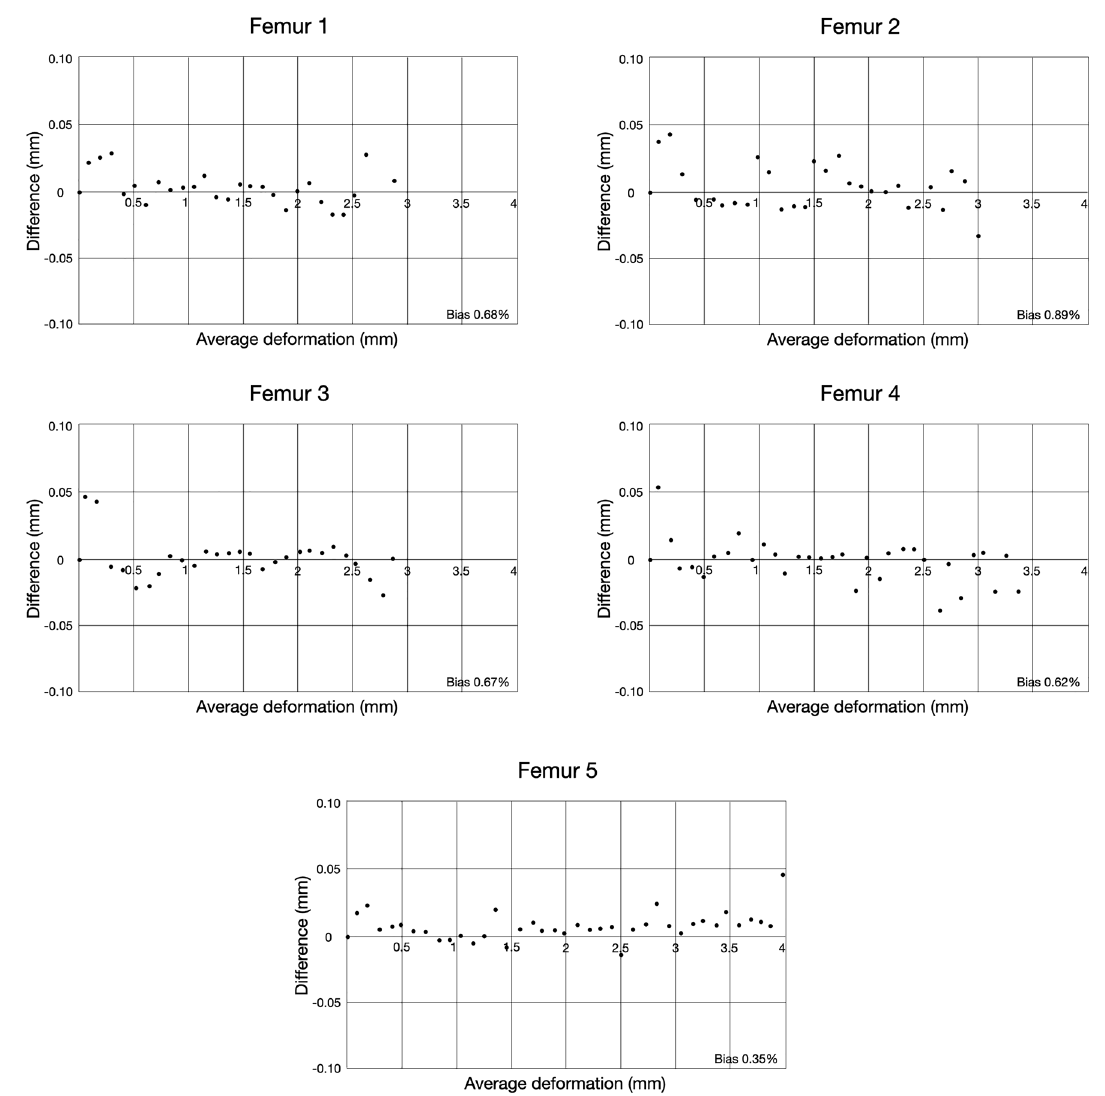
Fig. 11 Bland–Altman deformation analysis of the five femur